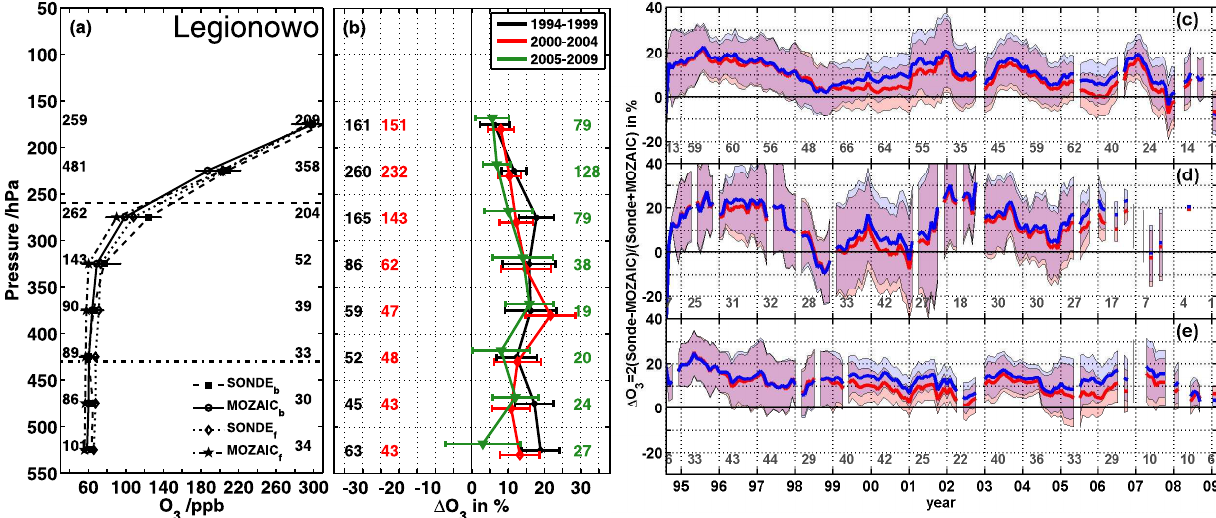
Fig. 5. Comparison of ozonesondes with MOZAIC measurements. As for Fig. 3, but for Legionowo. 00.050.10.150.2 Fig. 6. Annual statistical distribution of the background current ib 2 used to process Legionowo ozonesonde data. Note that ib 2 is not reported to the archives for every launch and data prior to 26 Jan- uary 1995 were not reported to the WOUDC archive.